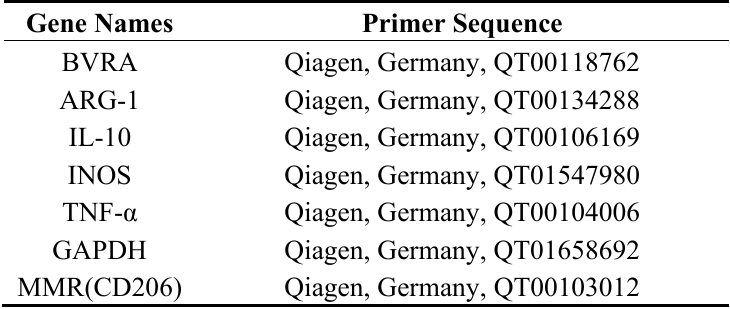
Table 1. Gene names and primer sequences used for